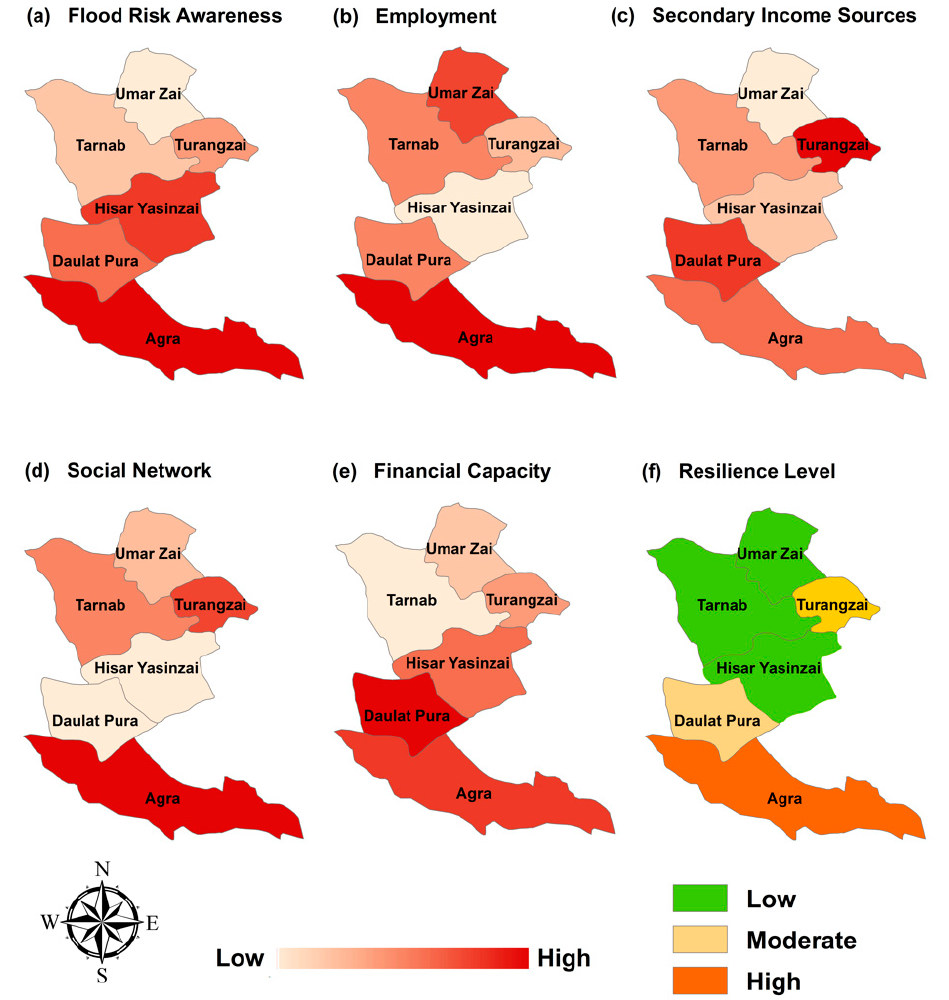
Figure 10. Geographical distribution of indicators and levels of resilience ( a ) represents the geographical distribution of households’ flood risk awareness; ( b ). represents the geographical distribution of households with employment; ( c ) represents the geographical distribution of households with secondary income sources; ( d ) represents the geographical distribution of households with social network; ( e ) represents the geographical distribution of household with financial capacity for recovery; and ( f ). represents the geographical distribution of households’ resilience level. Table 6. Household resilience to floods.